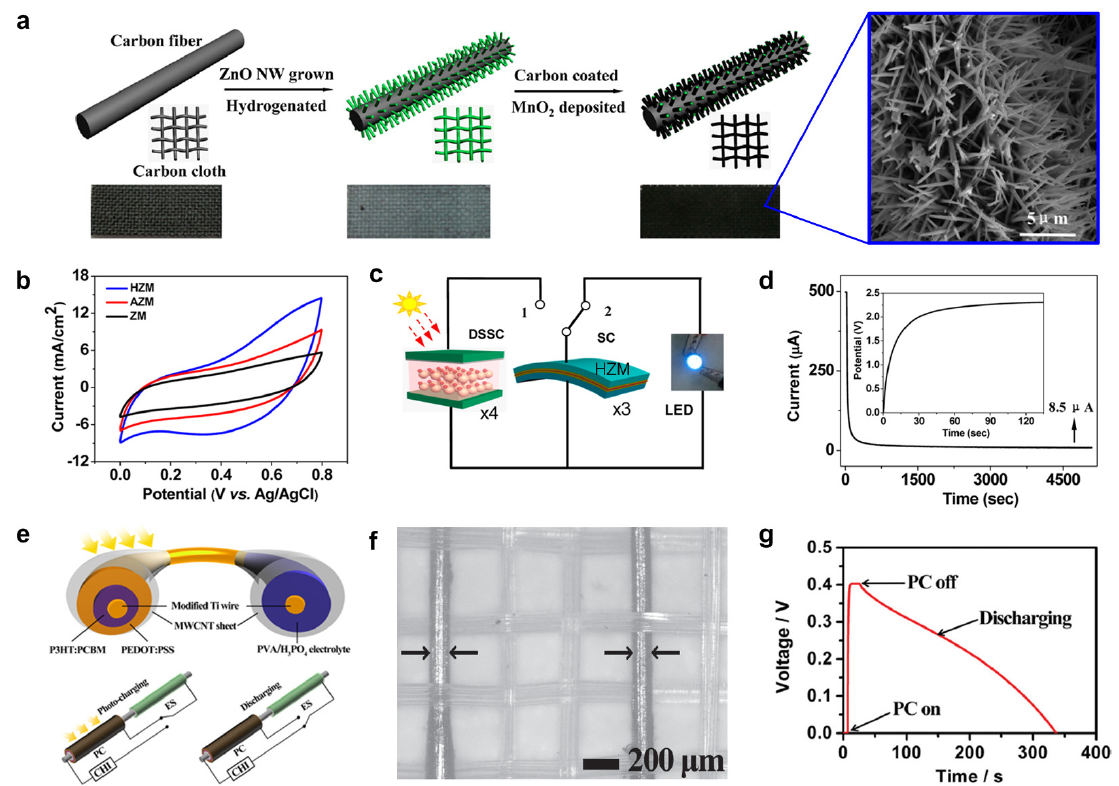
Figure 11. ( a ) Schematic fabrication process and SEM image of a hydrogenated single crystal ZnO (HZM) and amorphous ZnO-doped MnO 2 core-shell electrodes; ( b ) Current-potential characterization with different electrodes with scan rates of 100 mV/s; ( c ) Design of a stand-alone self-powered system consisting of dye-sensitized solar cells (DSSCs), SCs, and LEDs; ( d ) Leakage current characteristics of three SCs in series and voltage profile (inset) charged by four DSSCs in series; ( e ) Schematic illustration and circuit connection mechanism in the process of charging and discharging of photovoltaic aligned MWCNT sheet as two electrodes; ( f ) Photography of energy fibers woven with each other to form flexible textiles; ( g ) Charging-dischargin g curve with a current of 0.1 μ